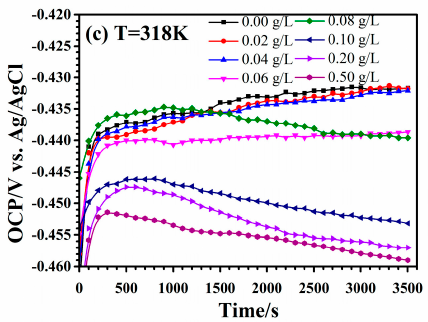
Figure 2. Open circuit potential curves of C-steel in 1 M HCl solution with different concentrations of Eriobotrya japonica Thunb. leaf extract (EJTLE) at ( a ) 298 K; ( b ) 308 K; and ( c ) 318 K.